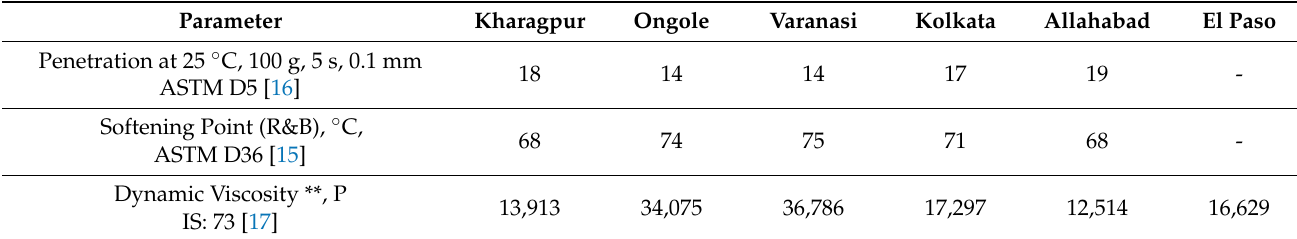
Table 4. Results of Tests Conducted on Recovered RAP